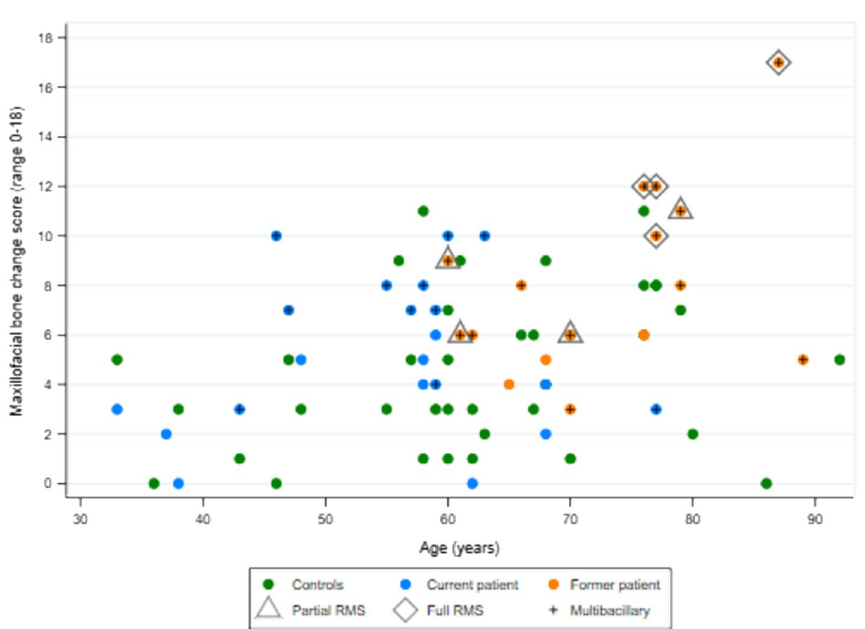
Figure 4. Correlation between maxillofacial bone alterations score and age in current and former Hansen’s disease patients and non-Hansen’s disease controls (see Table 4 for correlation